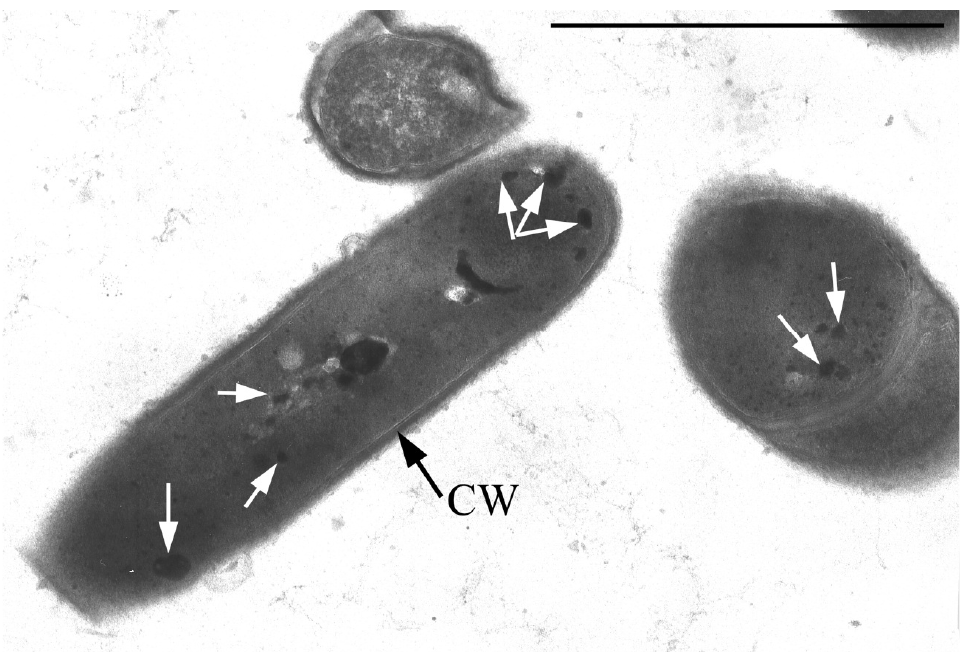
Figure 4. Ultrathin section of G. polyisoprenivorans 135 resting cells. Transmission electron microscopy. Designation: CW—cell wall; white arrows indicate electron-dense acidocalcisome-like inclusions.